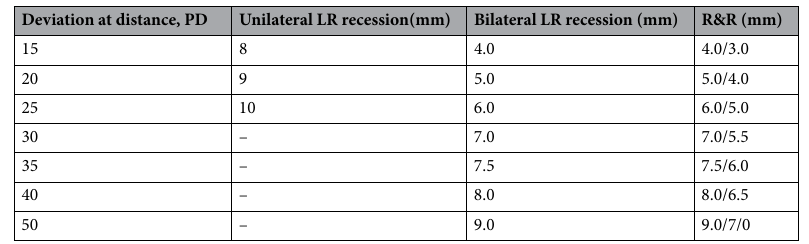
Table 1. Surgical table based on the angle of distant deviation. PD prism dioptres, LR lateral rectus, R and R unilateral lateral rectus recession and medical rectus